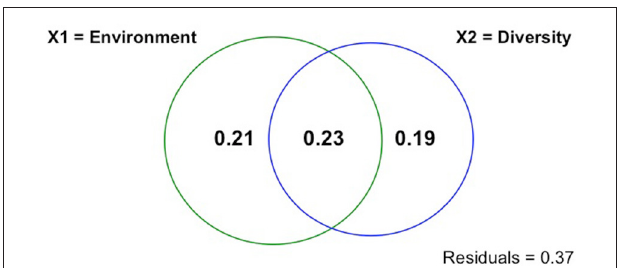
FIGURE 4 | Venn diagram illustrating results of variation partitioning of benthic fluxes explained by environmental variables and functional diversity (FD) indices. X1 = environmental variables and X2 = functional diversity indices. Numbers correspond to variation explained by different fractions: environmental variable only = 0.21, FD indices only = 0.19, and intersection of environmental variables and functional diversity indices =